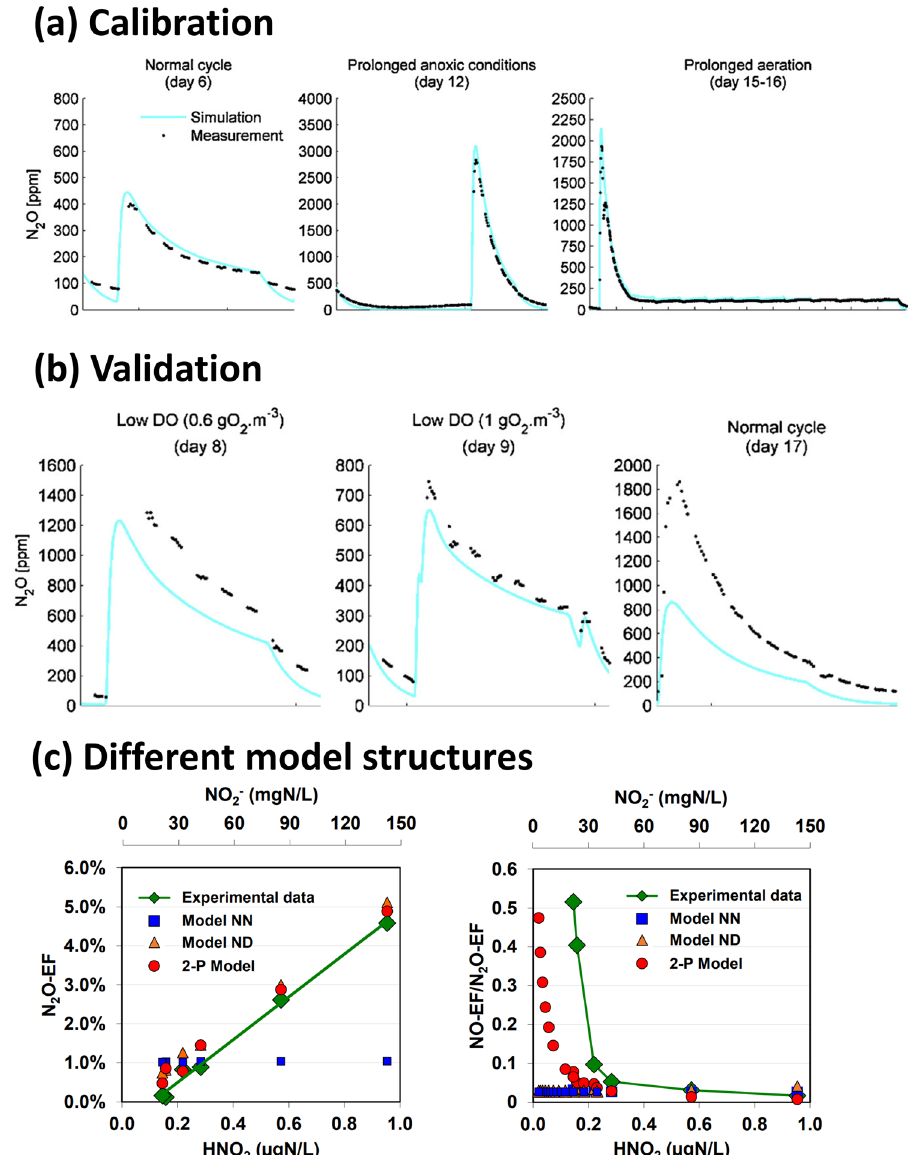
Fig. 3 Performance of some N 2 O models in literature. Illustrations in a and b are from Mampaey et al. 55 that shows a two pathway N 2 O model application to describe process data from a full-scale SHARON reactor: (top) the calibration results for gas-phase N 2 O measurements using a calibration dataset and (middle) the model validation results from using a validation dataset. The illustration in c is from Pocquet et al. 56 , presenting a comparison of single pathways versus two-pathway models to describe N 2 O and NO emission factors from a lab-scale SBR study. It is noted that most municipal wastewater treatment plants work at lower NO 2 levels (lower than 30 mgN/L), where model deviations from the measurements are signi fi cant. Figures reused with permissions from Mampaey et al. 55 copyright (Elsevier, 2013), and Pocquet et al. 56 copyright (Elsevier, 2016), ML tasks, as found in recent literature 29,30,60 . For instance, a spatial graph-based molecular representation of amino acid residue pairs has allowed AlfaFold 61 , an AI program developed by DeepMind, to perform 3D protein structure predictions far more accurately than ever made. Similarly, the interactions and the metabolic functions of microorganisms present in activated sludge systems and how they affect treatment plant performance metrics, such as N 2 O emissions can be studied using graph-based featurizations extracted from their metagenomics data and thereby used in, including but not limited to, convolutional type neural networks. Such networks have already found uses to classify metagenomics data using patristic distance de fi ned on the phylogenetic tree as a proximity measure 62 . Therefore these models can be explored to